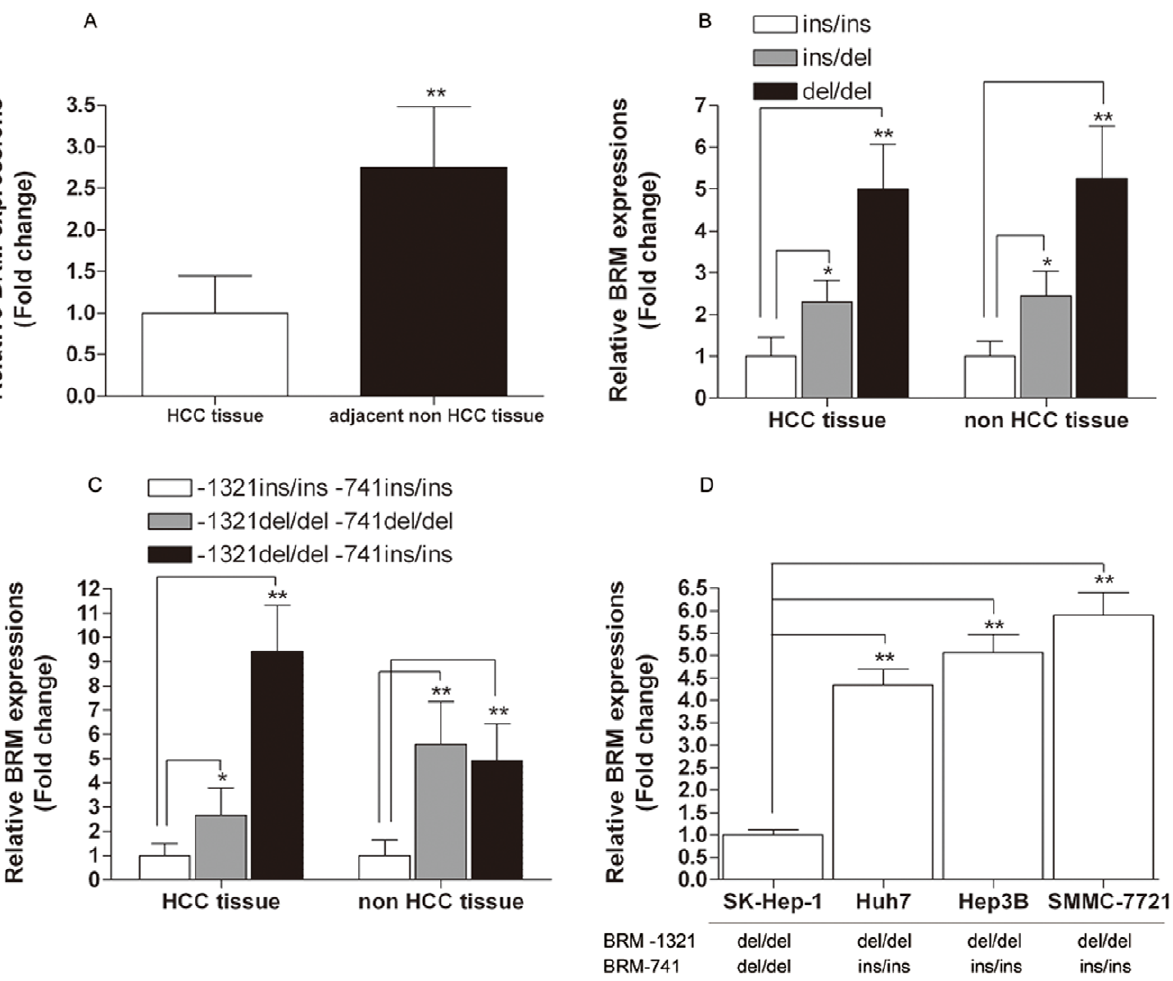
Figure 2. BRM expression in HCC tumor tissues vs. non-tumor tissues and its correlations between BRM-1321 indel polymorphism as well as corresponding haplotypes. ( A ) Relative BRM expression in HCC tumor tissues vs. non-tumor tissues (n=72); ( B ) Relative BRM expression in three genotypic groups of BRM-1321 ( 2 1321 ins/ins, n=10, 2 1321 ins/del, n=32, 2 1321 del/del, n=30); ( C ) Relative BRM expression in different haplotype groups (haplotype: 2 1321 ins/ins-741 ins/ins, n=6, haplotype: 2 1321 del/del-741 del/del, n=11, haplotype: 2 1321 del/del- 741 ins/ins, n=4); ( D ) Relative BRM expression in hepatoma cell lines with different haplotypes. Data represented as mean 6 SEM. *indicates P , 0.01, **indicates P , 0.001 compared within the same group (HCC tissue or non HCC tissue).